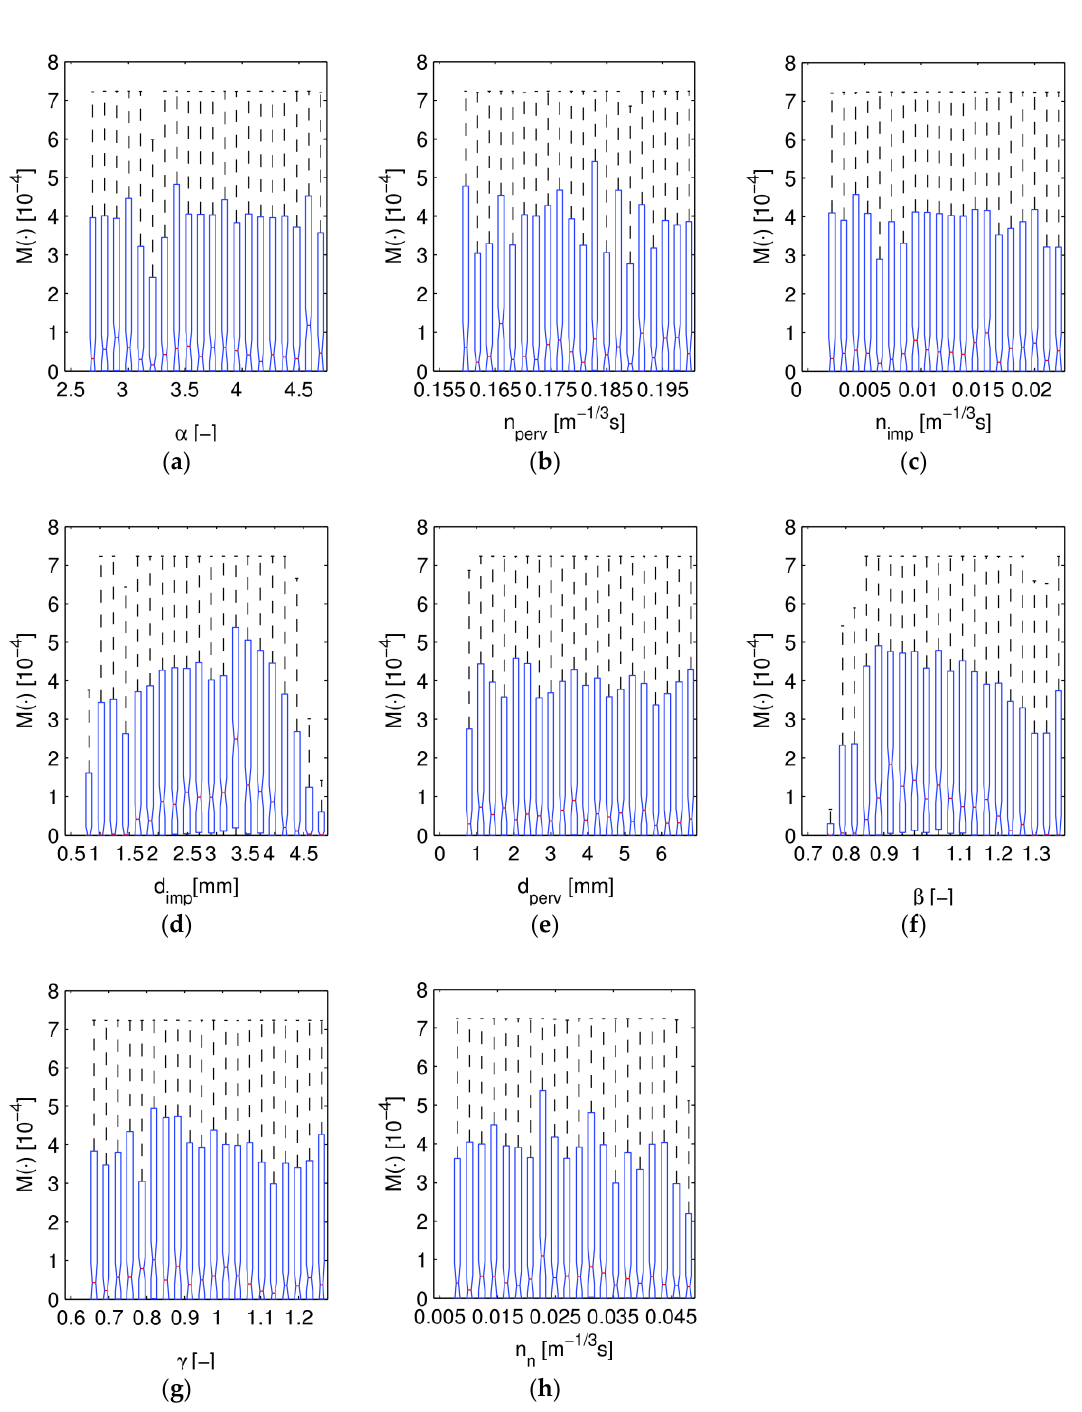
Figure 3. Box-plots for likelihood function values in the respect of parameter values (parameters symbols explained in Table 1).